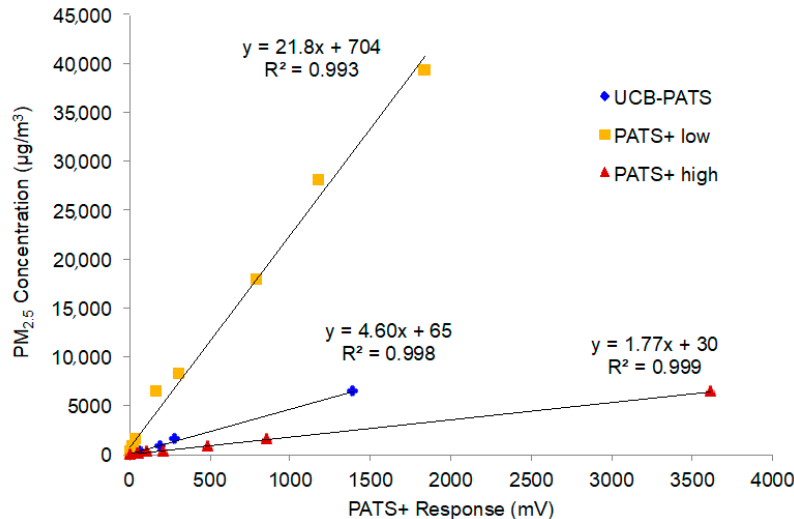
Figure 1. Relationships between PATS+ photoelectric response (low and high sensitivity channels in mV) and PM 2.5 concentrations based on laboratory chamber tests. Each point represents 15-min mean concentrations during a particle exposure event. The Y-axis is based on calibrated DustTrak readings.